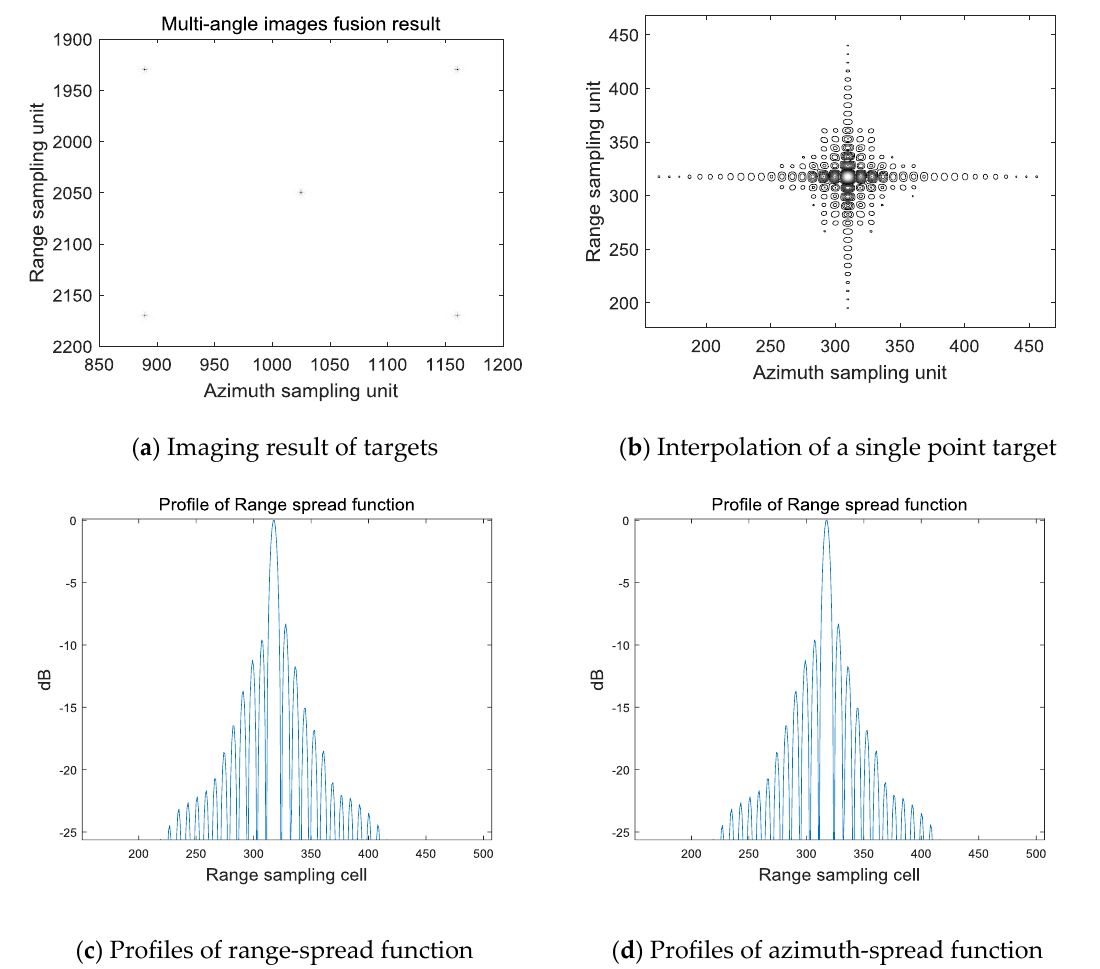
Figure 14. Result after image fusion.